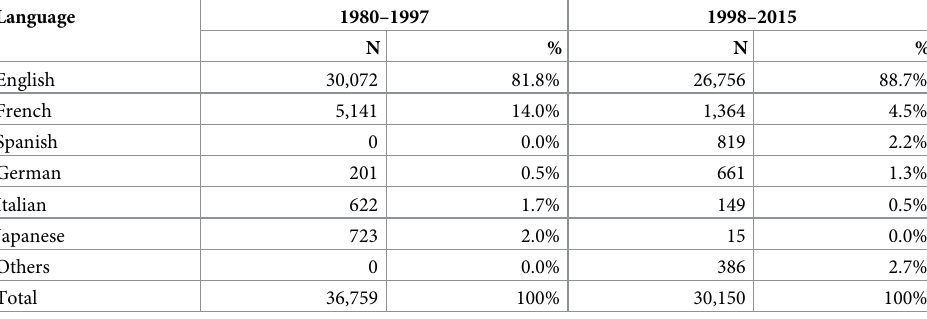
Table 1. Number and percentage of articles by language, 1980–1997 and